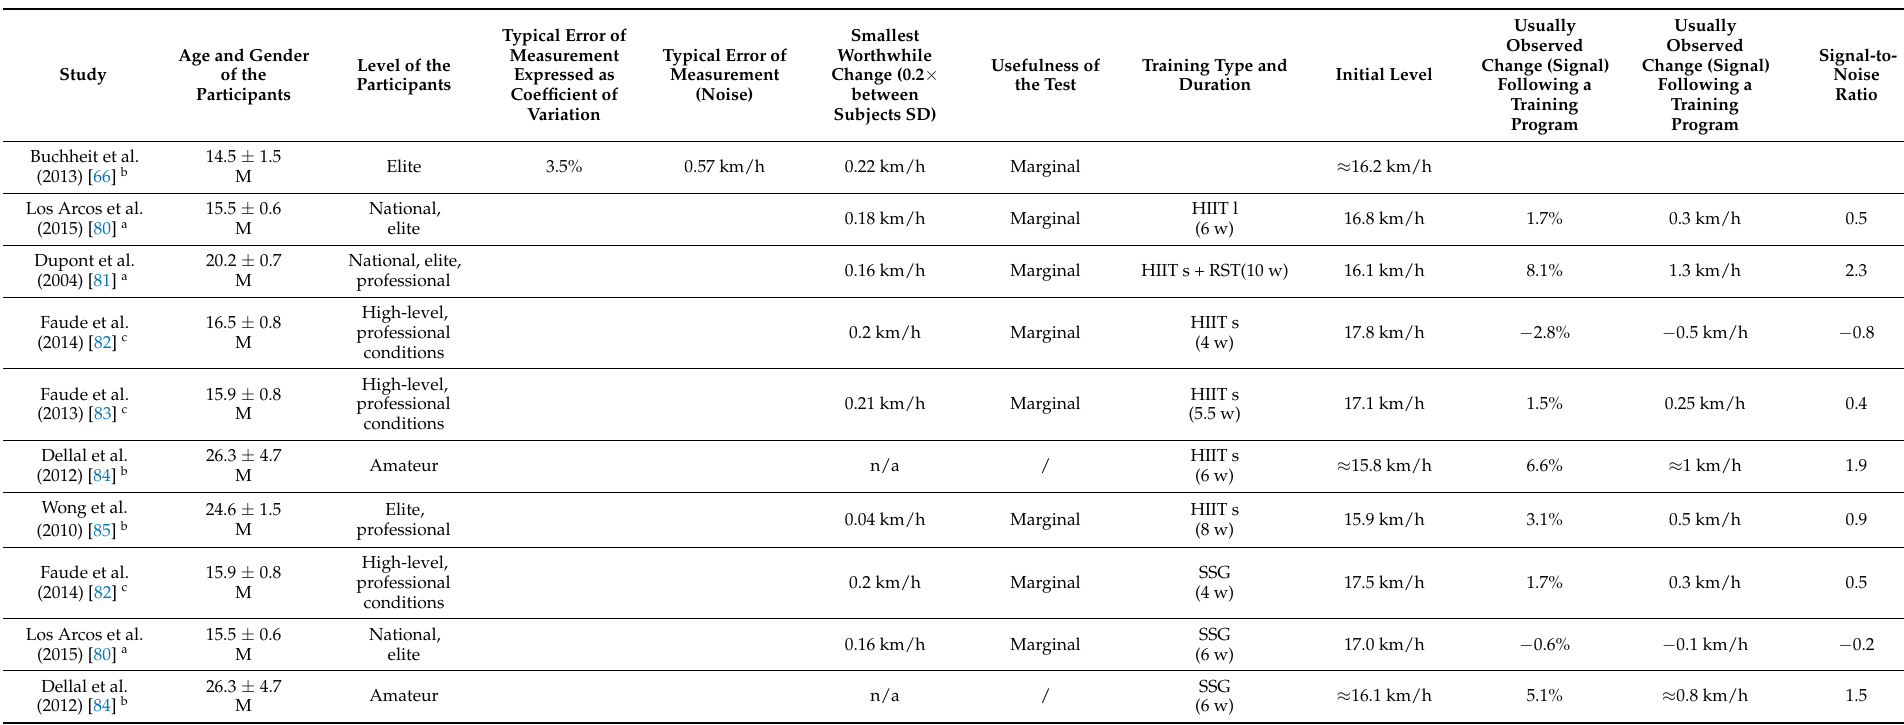
Table 1. Metric characteristics of the University of Montreal Track Test or Vam Eval test extracted from studies conducted on soccer